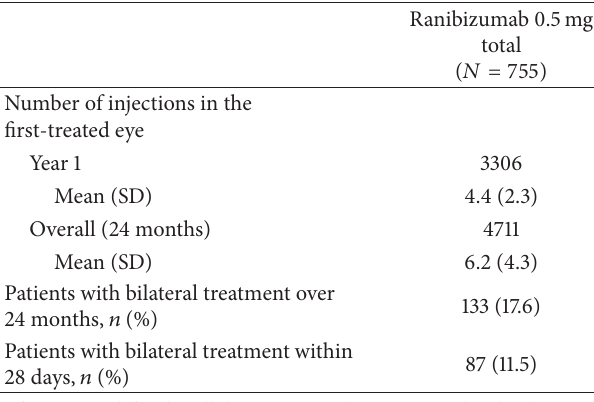
Table1:Treatmentexposureandtheincidenceofbilateraltreatment (safety